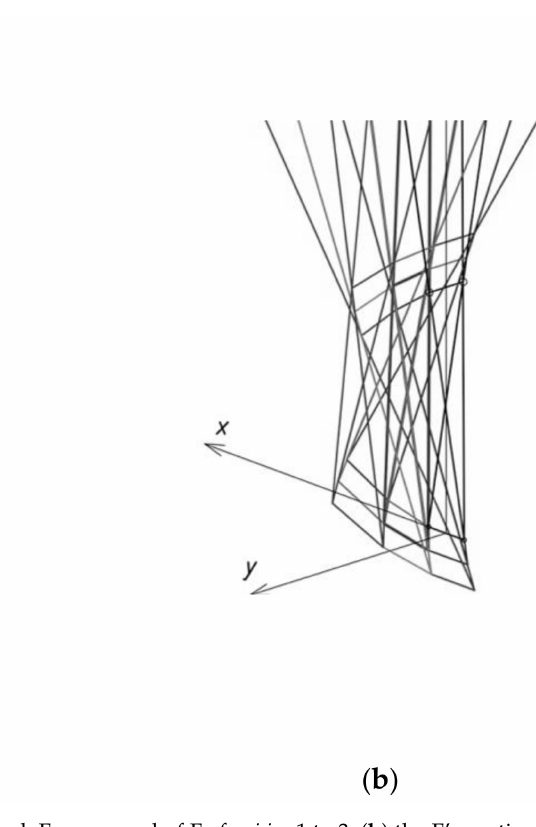
Figure 19. ( a ) The first quarter of the reference network Γ composed of Γ ij for i,j = 1 to 3, ( b ) the Γ ’s